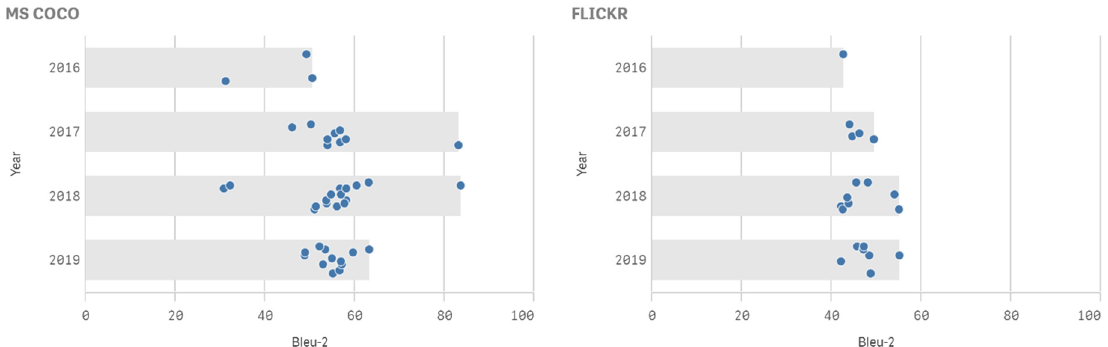
Figure 2. Bleu-2 results by year on MSCOCO ( left ) and Flickr30k ( right ).